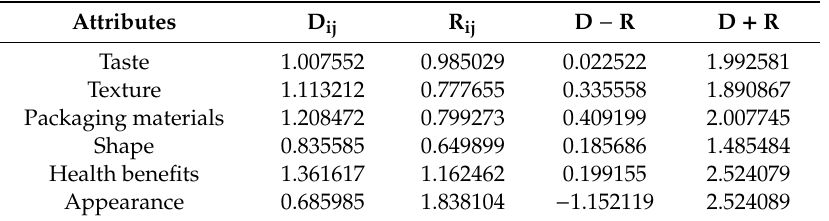
Table 9. Values of attributes’ relationships.